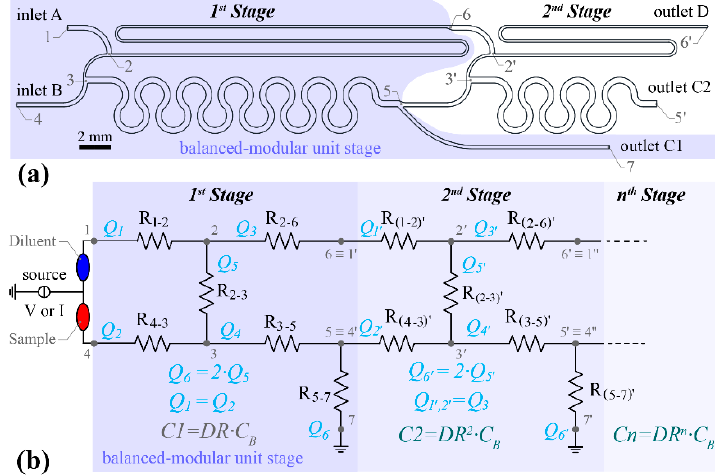
Figure 2. The two-stage stepwise serial diluter of the PCB based device ( a ) design overview highlighting the balanced modular unit stage ( b ) electrical analogous resistor-base network of an n-stage serial diluter design. The dilution ratio per stage is DR=2:3 .